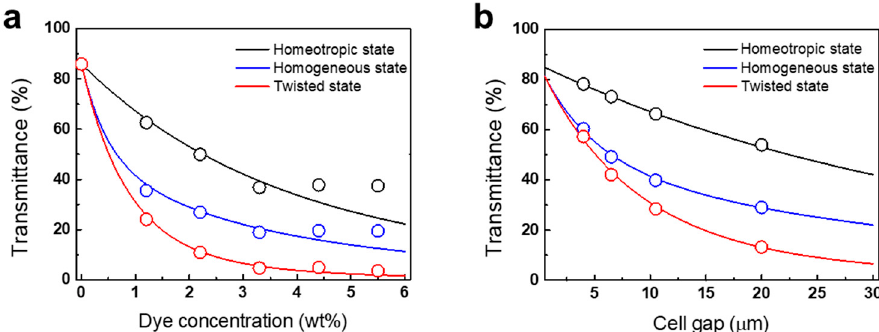
Figure 1. The calculated (solid line) and measured (empty circle) transmittances of LC cells as functions of the ( a ) dye concentration and ( b ) cell gap.